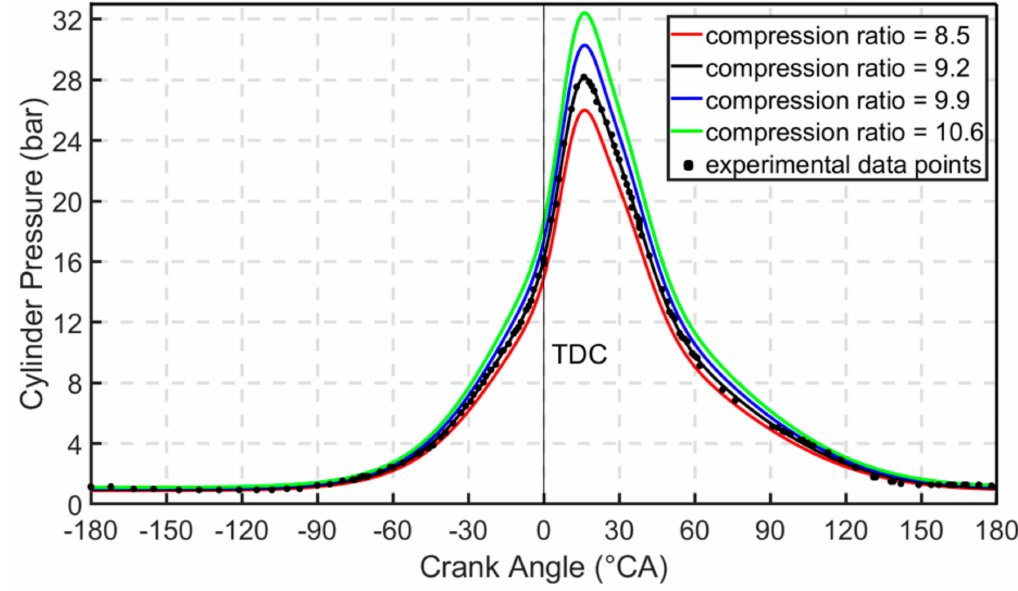
Figure A2. Comparison between cylinder curves with di ff erent compression ratios (full